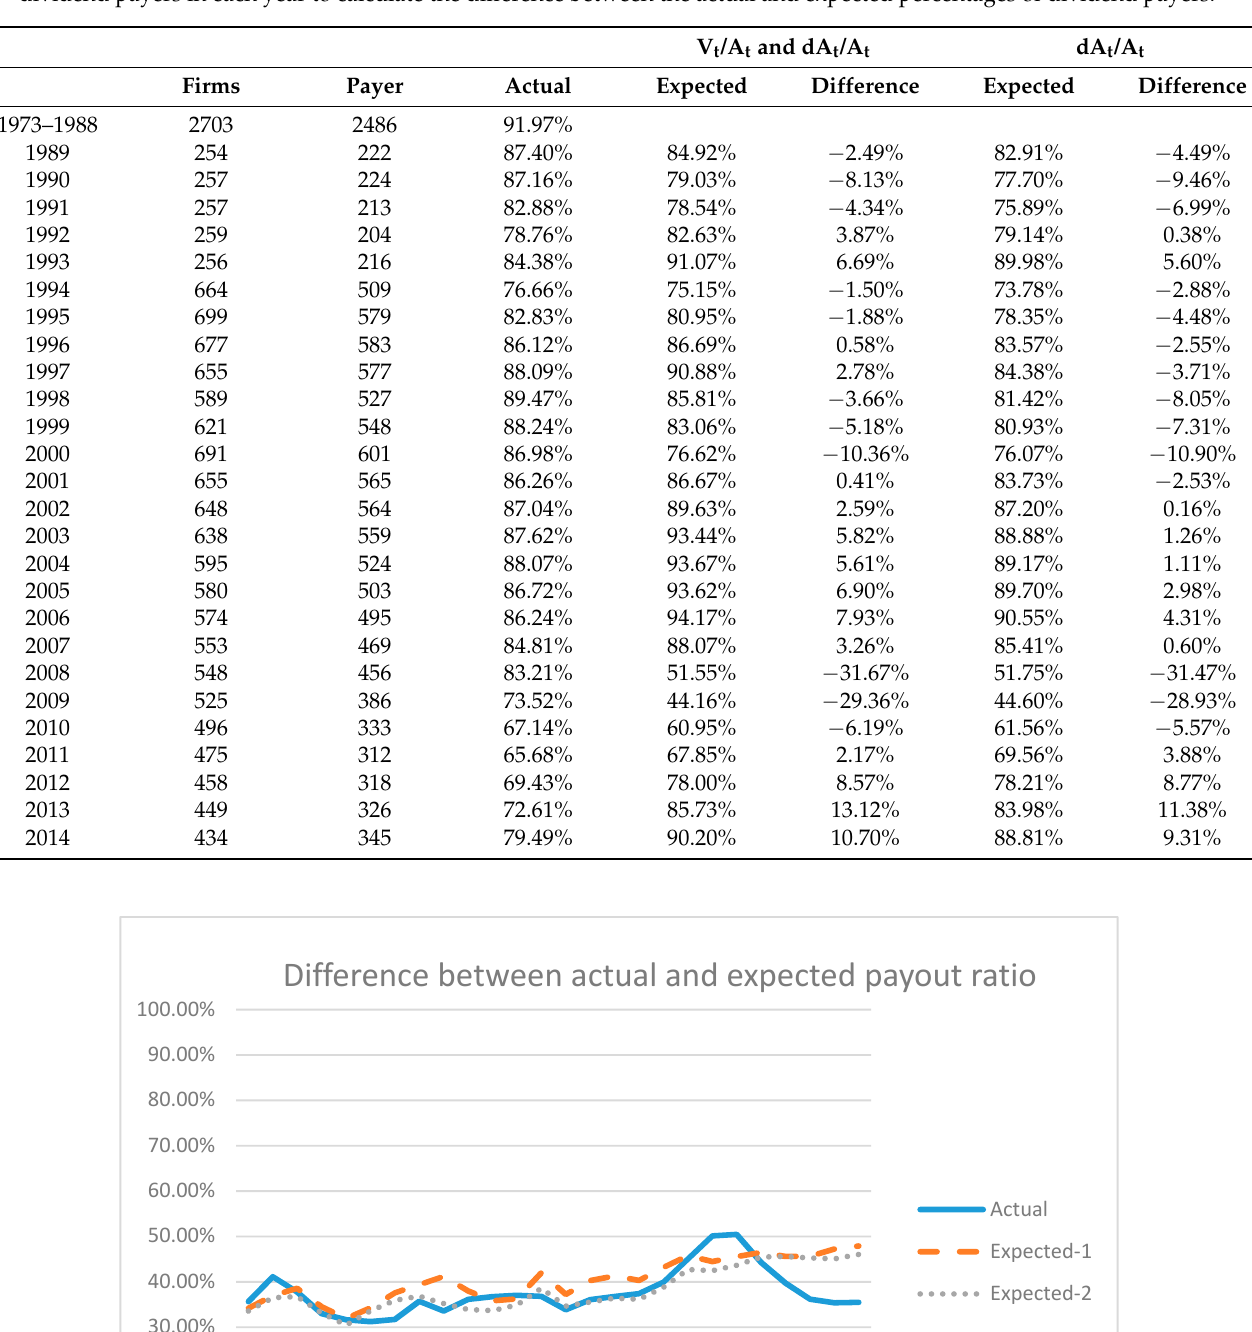
Table 6. Expected percentage of dividend payers versus actual payers based on models in Table 5. In this table, we apply the coefficients from the logit regressions in Table 5 estimated over the period 1973–1988 to the variable values in each year 1989–2014 to estimate the expected percentage of dividend payers in each year. We also show the actual percentage of dividend payers in each year to calculate the difference between the actual and expected percentages of dividend payers.